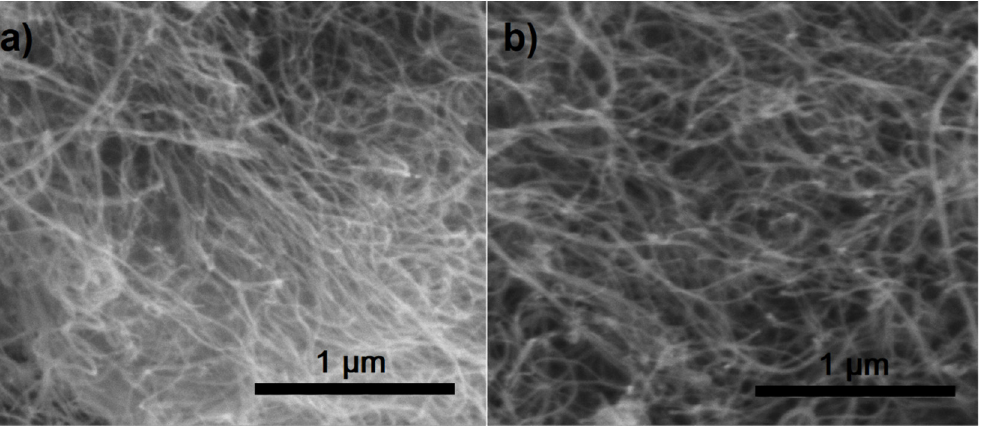
Figure 3. SEM images of MWCNT–Phos–AIBN ( a ) and MWCNT–Phos–UV ( b ). Pristine and functionalized MWCNTs were characterized using Raman, FTIR, and XPS spectroscopy. Raman spectra of MWCNTs samples recorded at a633 nm excitation wavelength are presented in Figure 4. Raman spectra of the pristine nanotubes are in accordance with reported data for this type of material and excitation energy [60–62]. Typical D and G bands were recorded for all samples. A comparison of Raman mode positions, full width at half maximum (FWHM), and I D /I G ratio are presented in Table 2. The decrease inthe I D / I G ratio was ascribed to the removal of amorphous carbon and the most defective MWCNTs during washing after functionalization [63,64]. Both the D band and G band of functionalized MWCNTs are widened, indicating the introduction of functional groups into the nanotube structures [65]. Moreover, the G bands of MWCNT– were obtained by Sunet al. [66] and described as evidence of the formation of C-P bonds.